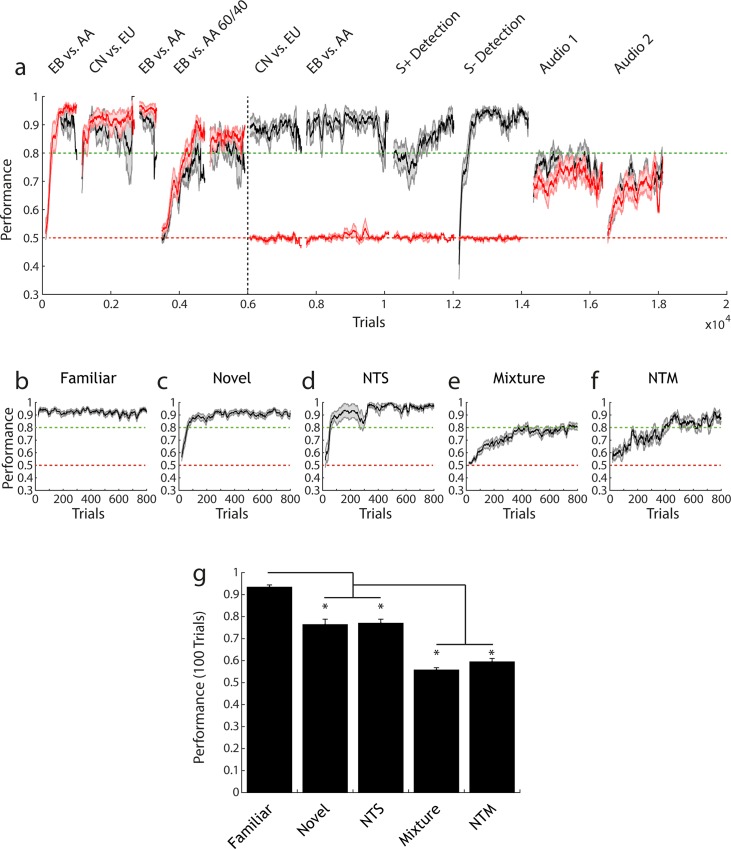
Large olfactory bulb lesions induce anosmia; task context affects performance rate (a) Performance (mean +/- sem) over several olfactory tasks for sham-injected (black, n = 6) and lesion animals (red, n = 8). Performance is calculated in a 100 trial moving average. Performance is shown before and after lesion induction (before and after black dotted line respectively). (b-g) Combined pre- lesion and sham performance for each distinct task context. All performance is shown calculated over a 20 trial moving average (mean +/- sem). (b) Familiar task: performing discrimination on a previously learnt odour pair (n = 38). (c) Novel task: odour pair has not been previously encountered (n = 32). (d) Non-trigeminal simple task: odour pair has not yet been encountered and both odours are non-trigeminally activating (n = 9). (e) Mixture task: discrimination between simultaneously presented odours in the ratio 60:40 vs. 40:60 (n = 31). (f) Non-trigeminal mixture task: same as in (e) but both odours are non-trigeminally activating (n = 9). (g) Performance in the first 100 trials (calculated over 20 trial sliding window) on each task type and statistically compared (1-way ANOVA with Tukey-Kramer correction for multiple comparisons, F = 65.13, p = 1.46x10-28). Novel and NTS task performance is significantly lower than familiar performance. Mixture and NTM task performance is significantly lower than all other tasks.